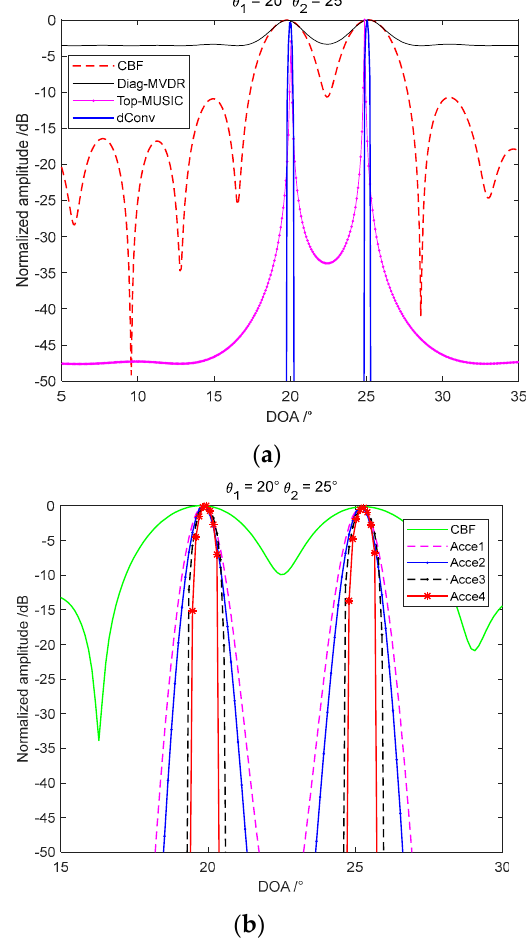
Figure 3. Imaging performance of deconvolution beamforming: ( a ) imaging comparison between different algorithms; and ( b ) imaging performance of different acceleration methods.